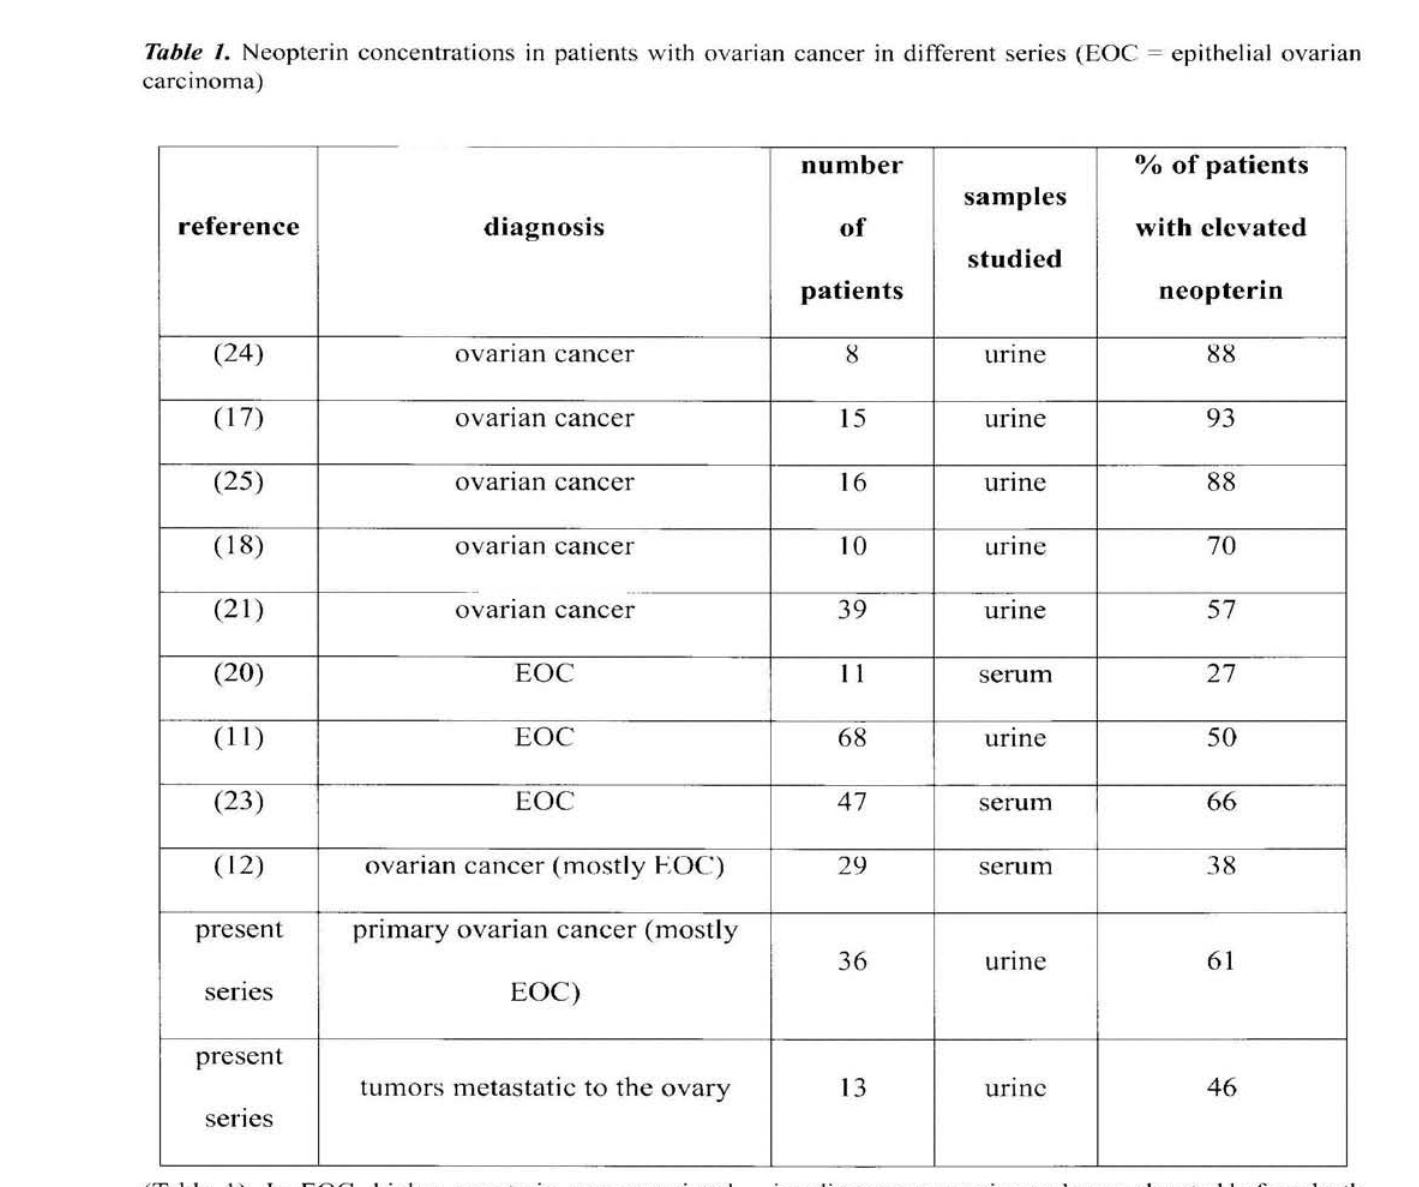
Table 1. Neopterin concentrations in patients with ovarian cancer in different series (EOC